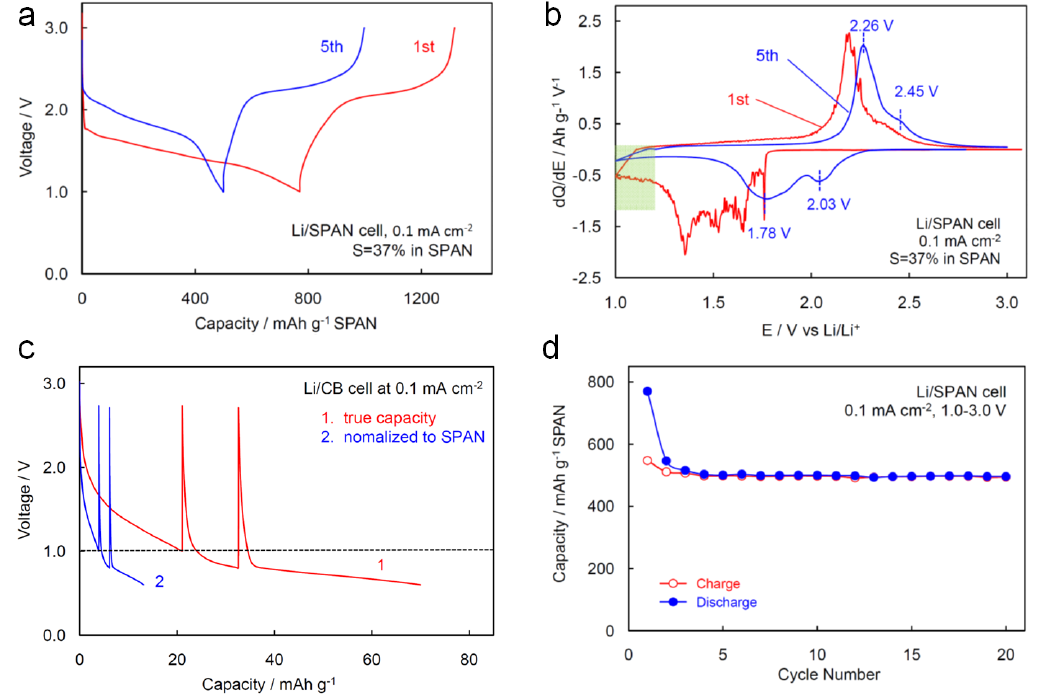
Figure 3. Electrochemical characteristics of a Li/SPAN cell (37% S in SPAN) and a Li/carbon black (CB) cell, respectively. ( a ) voltage profile of Li/SPAN cell; ( b ) differential capacity-potential plot of Li/SPAN cell; ( c ) irreversible capacity of carbon black; and ( d ) cycling performance of Li/SPAN cell.